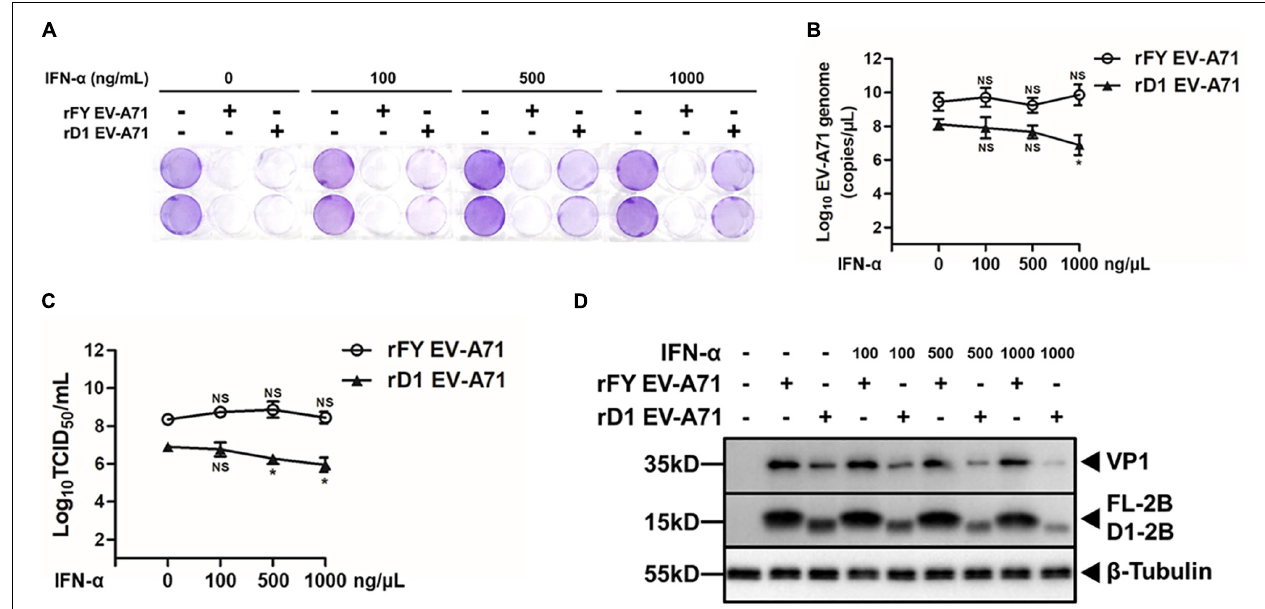
FIGURE 9 | Increased sensitivity of rD1 EV-A71 to IFN- α in infected cells. HeLa cells were pre-treated with IFN- α for 2 h, followed by infection with rFY or rD1 EV-A71 at an MOI of 1. (A) Cytopathic effects of infected cells pre-treated with IFN- α . Cells were fixed at 48 h p.i. and stained with 0.5% crystal violet. Darker crystal violet staining indicates more viable cells present after infection. (B–D) Decreased viral replication in rD1 EV-A71-infected cells treated with IFN- α . Total RNA was prepared from the infected cells, pre-treated with IFN- α , at 48 h p.i. for real-time RT-PCR to measure viral RNA copy numbers with the primers specific for VP1 gene (B) . Culture medium from the infected cells, pre-treated with IFN- α , were sampled at 48 h p.i. and infectious viral titers (TCID 50 ) were determined (C) . Error bars represented standard deviations of the results for three repeated experiments. Cell lysates were prepared from the infected cells, pre-treated with IFN- α , at 48 h p.i. for western blot analyses with antibodies for VP1, 2B, or β -Tubulin (D) .